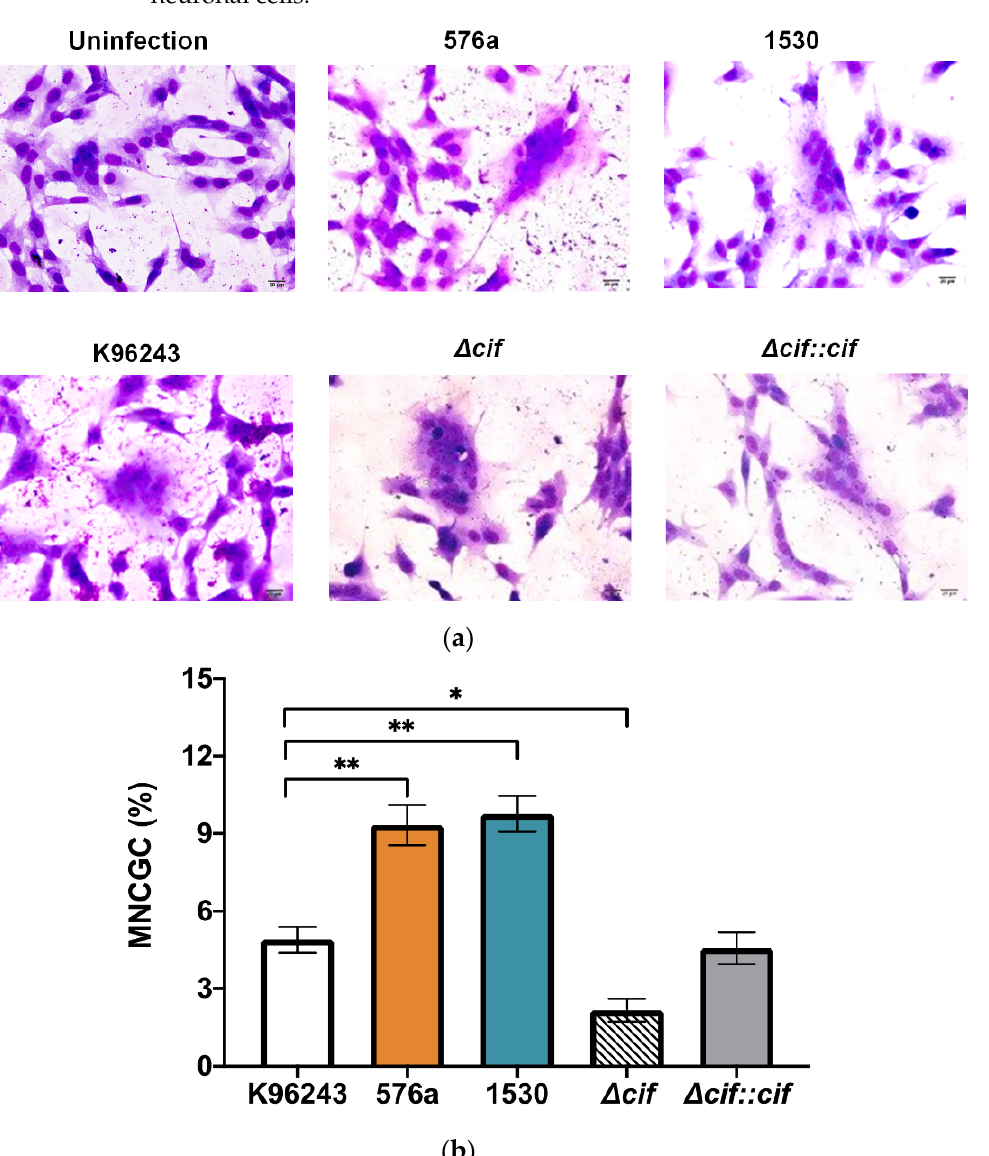
Figure 5. MNGC formation in SH-SY5Y cells. ( a ) MNGC formation induced by B. pseudomallei K96243, 576a, 1530, the cif- deleted mutant ( Δ cif ), and the complemented cif mutant strain ( Δ cif::cif ). Cells were stained with Giemsa. Images were captured by standard light microscopy with a 40× objective lens. ( b ) Percentage of MNGC formation induced by B. pseudomallei K96243, 576a, 1530, Δ cif , and Δ cif::cif strains. Values are shown as the mean ± SEM of three independent experiments. * p < 0.05, ** p < 0.01.